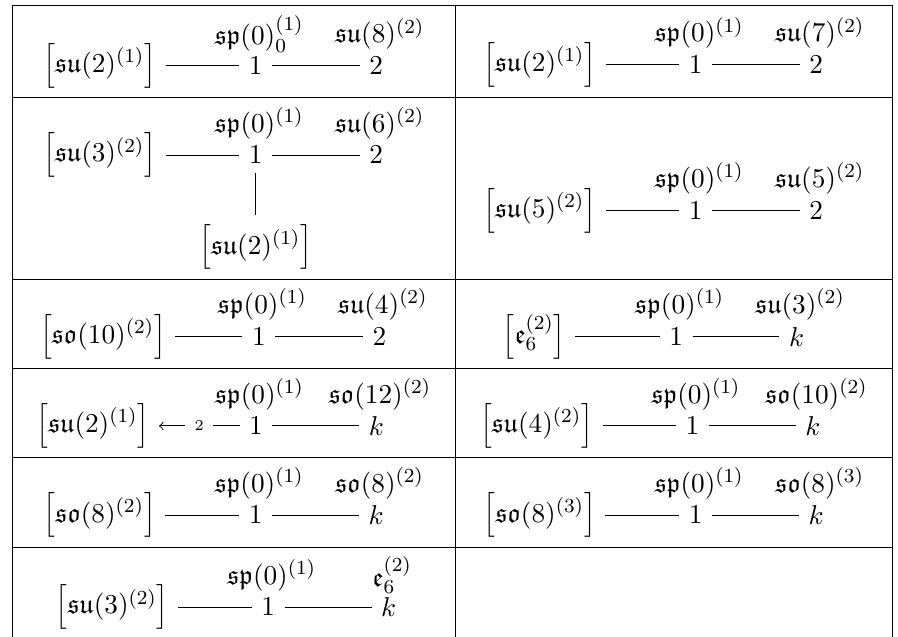
Table 8 . Possible localized flavor symmetries in 5 d KK theories for nodes with a trivial gauge algebra having no incoming directed edges. Continued in table